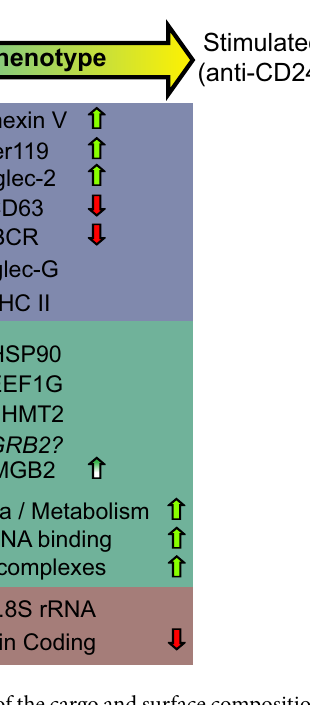
Figure 6. Summary diagram of the cargo and surface composition of MVs from isotype or CD24 stimulated cells. The differences in surface protein, luminal protein, and RNA transcriptome between basal and CD24 induced MVs are shown. No change indicated by = , absence indicated by X, a significant change indicated by arrows where arrows coloured with a gradient indicate a variable difference in abundance as detected by Western